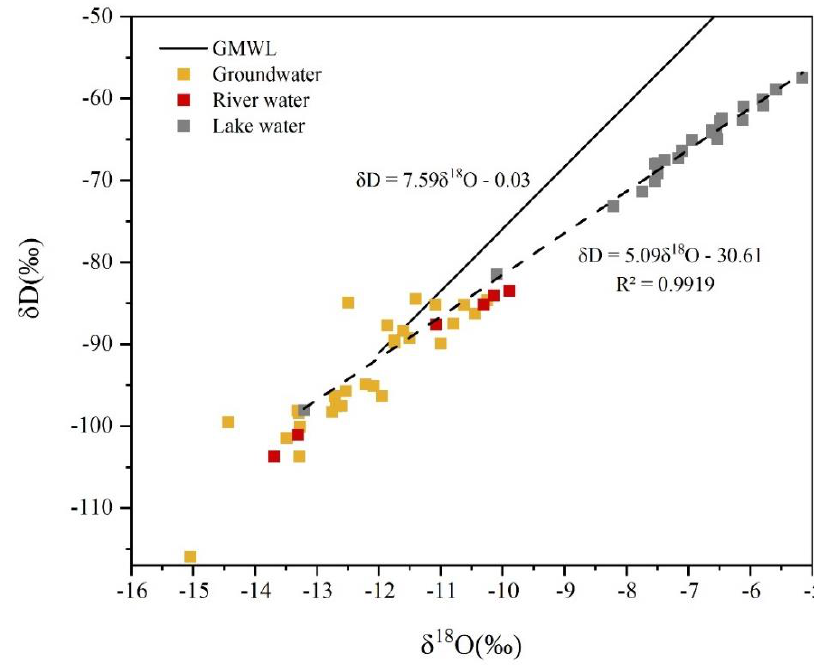
Figure 6. The relationship with the meteoric water line for the δD and δ 18 O in the water from the Hulun Lake regime (the dotted line is fitted with data from Hulun Lake).